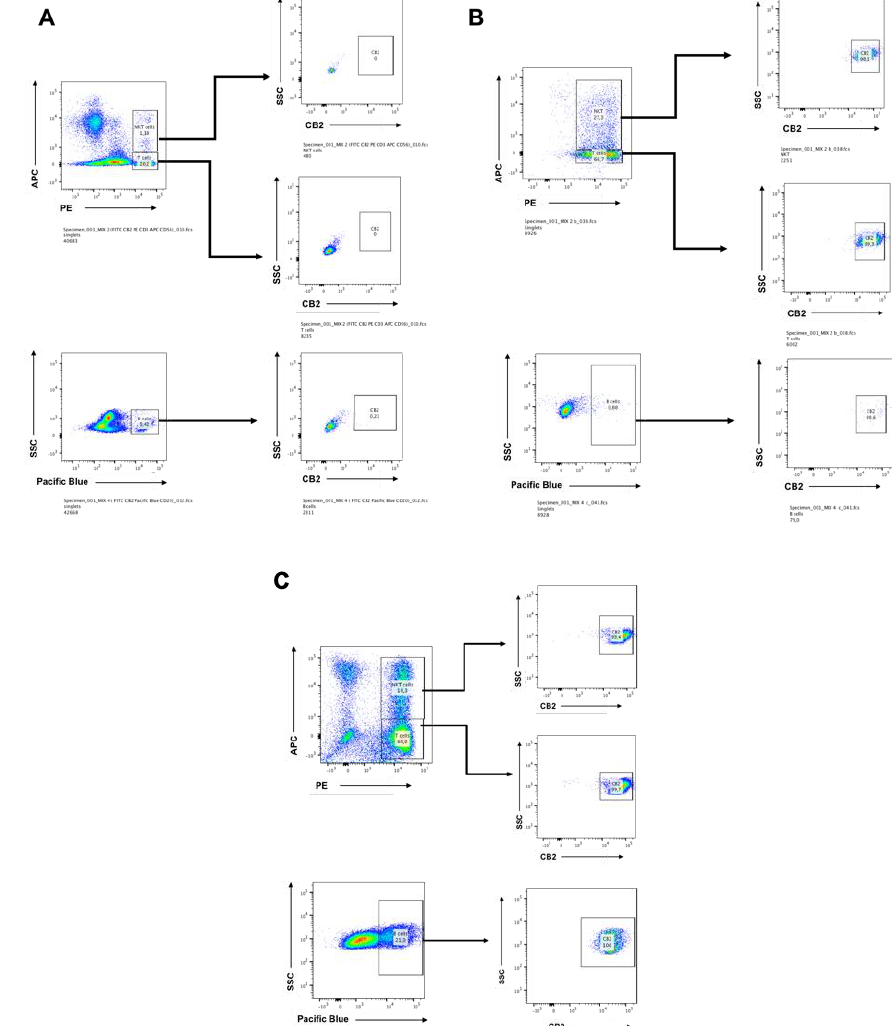
Figure 1. ( A ) The differential expression of CB2 receptor in the main cell subsets of human Cytokine- induced killer (CIK) cells, i.e., CD3+ T lymphocytes (CD4+ and CD8+), CD3+CD56+ NKT cells, and CD20+ B-cells. Both surface expression and intracellular CB2 expression were evaluated. The CIK cells were immunophenotyped at day 0 by flow cytometry. At day 0, CB2 expression was not detectable in any T lymphocytes subsets (CD3+ T lymphocytes 20.0%, CD3+CD56+ NKT 1.2%). Also, the B cells subset which was 5.4% did not express any CB2 receptor. ( B ) The CIK cells were immunophenotyped at day 14 by flow cytometry. Both surface expression and intracellular CB2 expression were evaluated. The T lymphocytes subsets were CD3+ T lymphocytes 66.7% and CD3+CD56+ NKT 27.3%. CB2 expression was dramatically upregulated within both CD3+ T lymphocytes (CD4+ and CD8+) 99.3% and the CD3+CD56+ NKT cells population 98.1%. The B cells subset was only the 0.9%. ( C ) The CIK cells were immunophenotyped on day 7 by flow cytometry. Both surface expression and intracellular CB2 expression were evaluated. The T lymphocytes subsets were CD3+ T lymphocytes 60.8% and CD3+CD56+ NKT 18.3%. CB2 expression was upregulated within both CD3+ T lymphocytes (CD4+ and CD8+) 99.7% and the CD3+CD56+ NKT cells population 99.4%. The B cells subset was the 21%, and all were positive for CB2